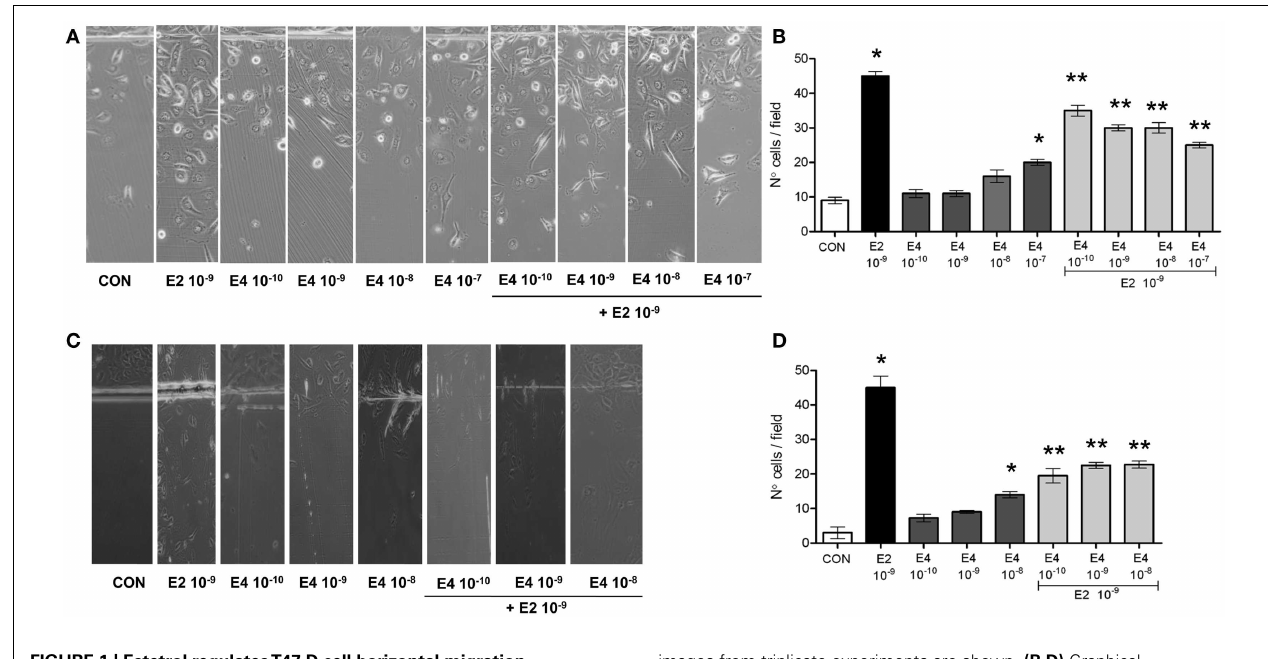
FIGURE 1 | Estetrol regulatesT47-D cell horizontal migration . Steroid-deprived, growth synchronized ER + T47-D cells (A,B) or human umbilical vein endothelial cells (HUVEC) (C,D) were exposed to 10 − 9 M E2 or to increasing concentrations of E4, or to the combination of the steroids. Cells were scraped from the culture dish and the number of cells migrated over the start line was assayed after 48h. (A,C) Representative